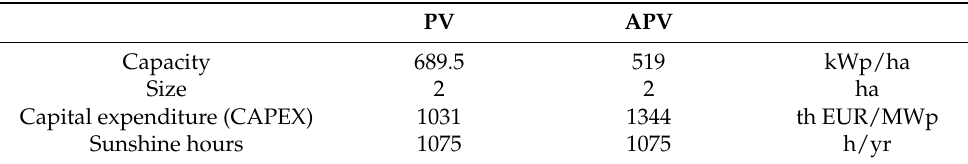
Table 1. Baseline scenario.